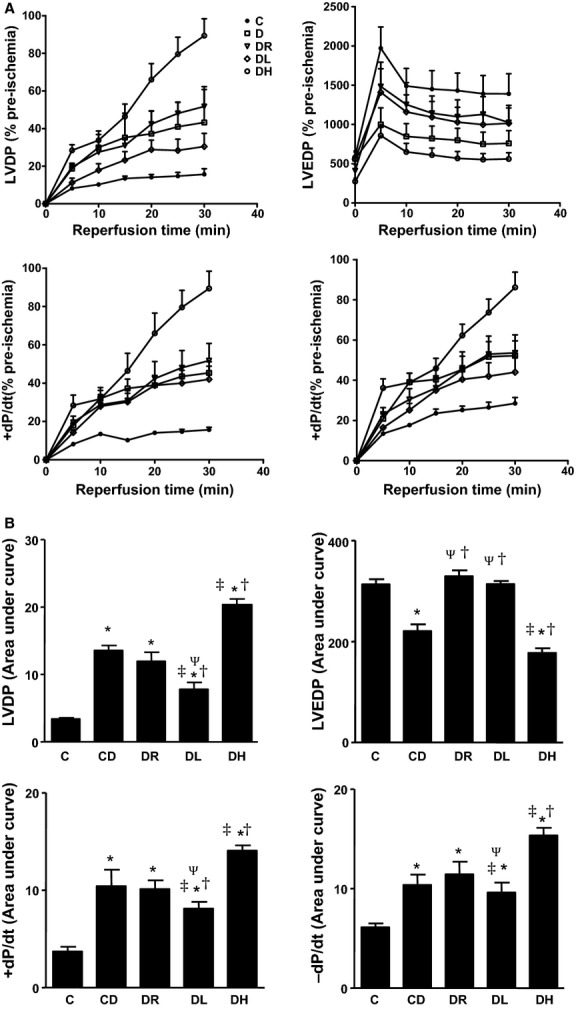
Effect of T1DM and exercise training modality on left ventricle mechanical function. The data are presented in time course format (A) and area under the curve measurement (B). Compared with control and sedentary diabetic high intensity aerobic exercise training lead to enhancement in postischemic LVDP, +dP/dt, −dP/dt and LVEDP in rat hearts following ischemic stress. *different than C; †different than CD; ‡different than DR; Ψdifferent than DH; P < 0.05, based on a one‐way ANOVA. Data presented as a mean ± SE.